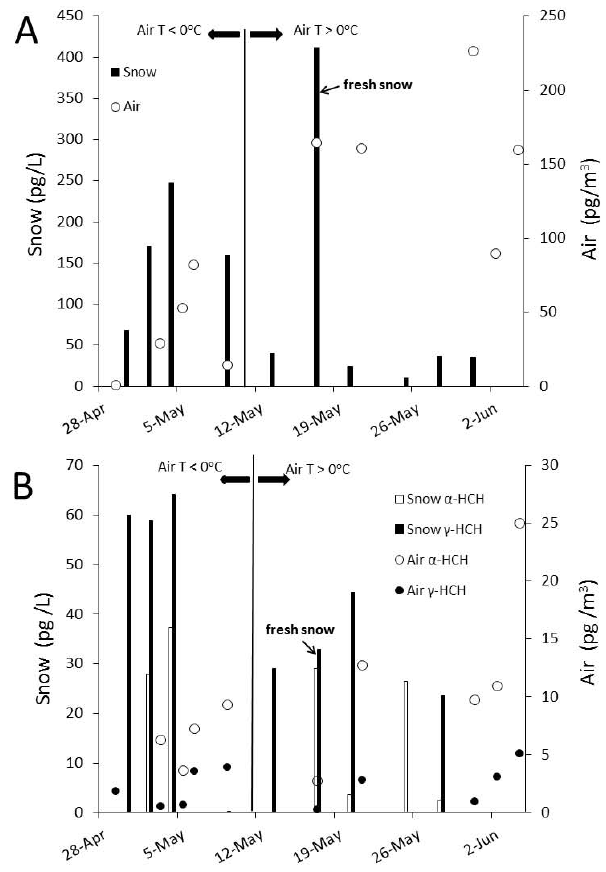
Fig. 5. Time-series of HCB (top) and α and γ -HCH (bottom) con- centrations in snow and air measured in the Amundsen Gulf, Cana- dian Arctic (April–June 2008). The vertical lines approximately de- note the period when average air temperatures were at or above 0 ◦ C. HCB and HCH concentrations in air are shown on the sec- ondary y-axes. The average daily air temperature fluctuated around 0 ◦ C from mid-May onwards with a corresponding reduction in the snowpack depth and cover and occurrence of melt-ponds on the sea- ice surface by late May. When air temperatures are > 0 ◦ C, concen- trations of HCB and HCHs are generally lower in the snow (exclud- ing fresh snowfall) and the air concentrations are on average higher than when air temperature was < 0°C, indicating exchange between the snowpack and the atmosphere. Data from Codling et al.